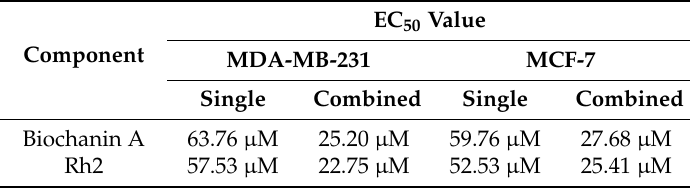
Figure 1. Antiproliferative effects of BA, Rh 2 , and the combination of BA with Rh 2 on MDA ( A ) and MCF-7 ( B ) human breast cancer cell lines (mean ± SD, n = 3). Each value represents the mean ± SD of triplicate biological experiments. Table 1. The EC 50 values of BA and Rh 2 towards MDA-MB-231 and MCF-7 cells.